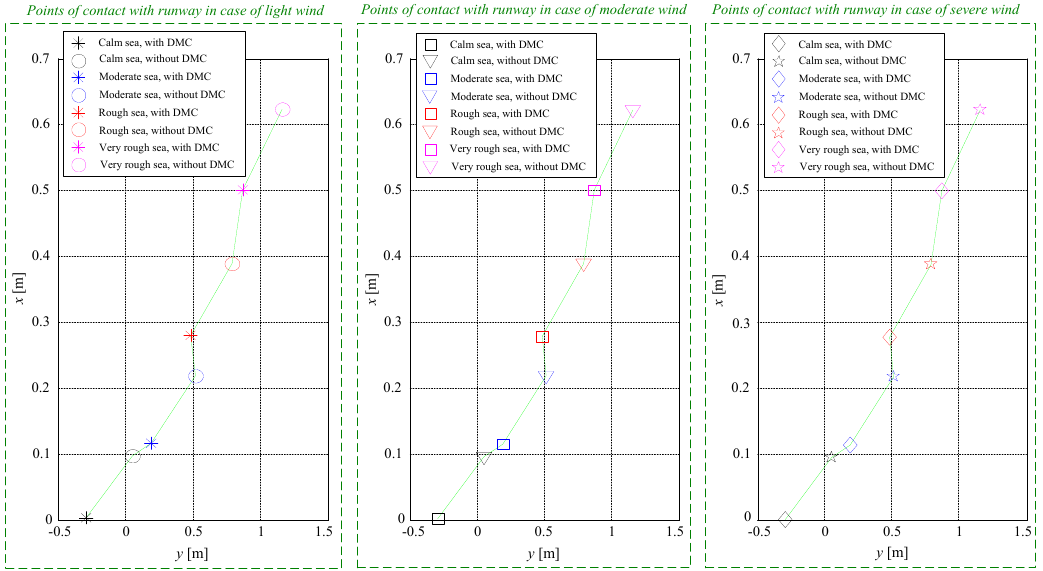
Figure 13. The distribution of the landing points depending on sea state and wind intensity.